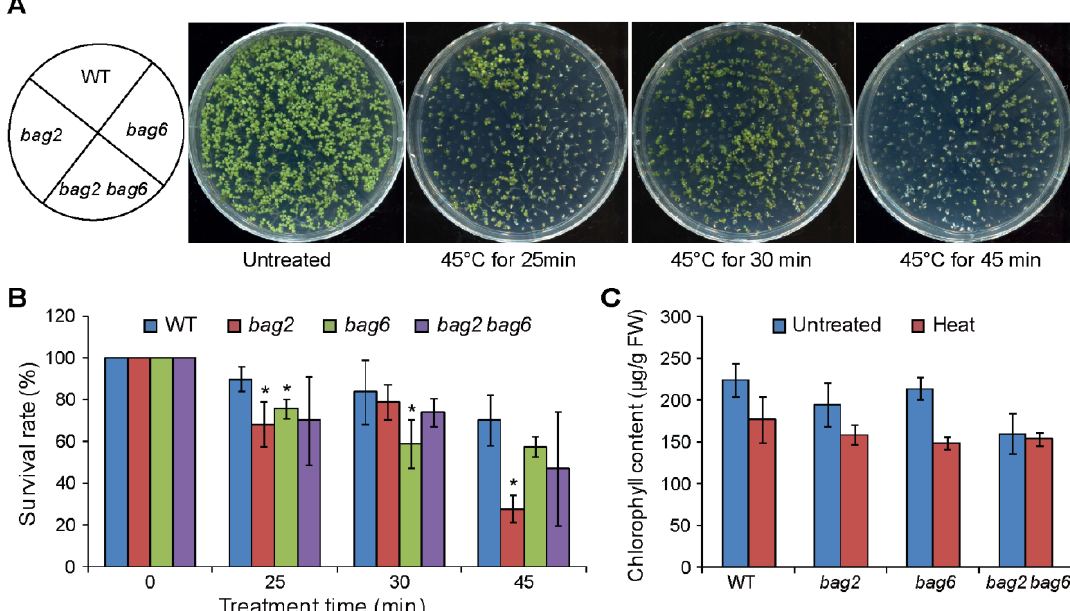
Figure 7. bag2 and bag6 mutants are hypersensitive to heat stress. ( A ) Phenotype of seedlings treated with heat stress; ( B ) Survival rates of WT, bag2 , bag6 , and bag2 bag6 mutants under heat stress. Five-day-old seedlings were placed at 45 °C for 25, 30, and 45 min and then resumed growth at 22 °C; ( C ) Chlorophyll content measured from seedlings grown on normal growth conditions and after 45 °C heat stress. The data represent the means ± SD of two independent experiments. * represent the significant differences at p < 0.05; ** represent p < 0.01 (Student’s t -test).